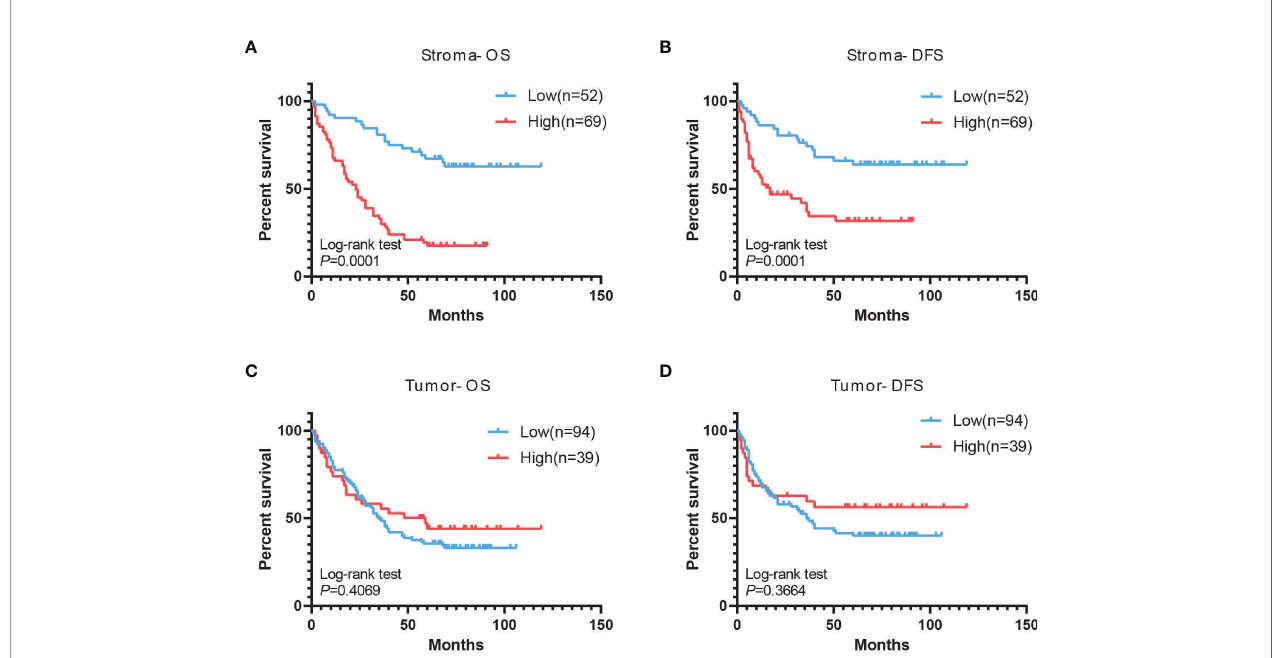
FIGURE 5 | Associations of CXCL14 expression in tissue with PFS and OS. (A, B) Kaplan-Meier analysis of overall survival and disease-free survival of lung cancer patients with stromal CXCL14 expression. (C, D) Kaplan-Meier analysis of overall survival and disease-free survival of lung cancer patients with tumor CXCL14